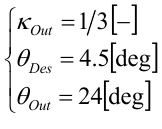
Fig. 8 through Fig. 10 show DELs of blade root flap-wise bending moment and